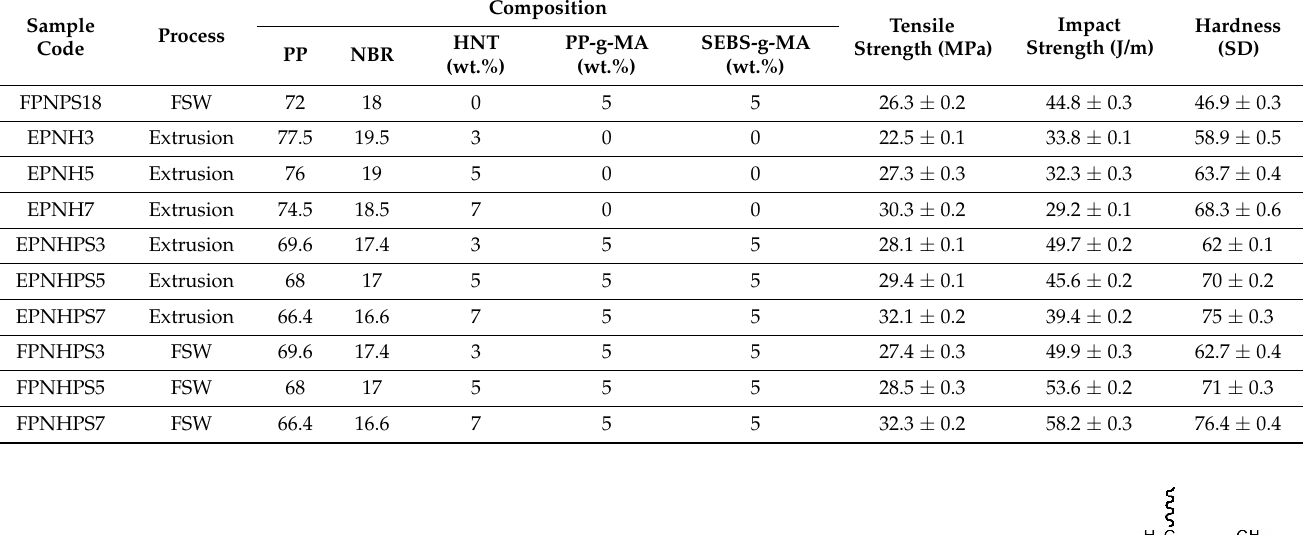
Table 3. Comparison of mechanical properties of extruded and FS-welded PP/NBR blends with or without dual compatibilizer and HNTs.